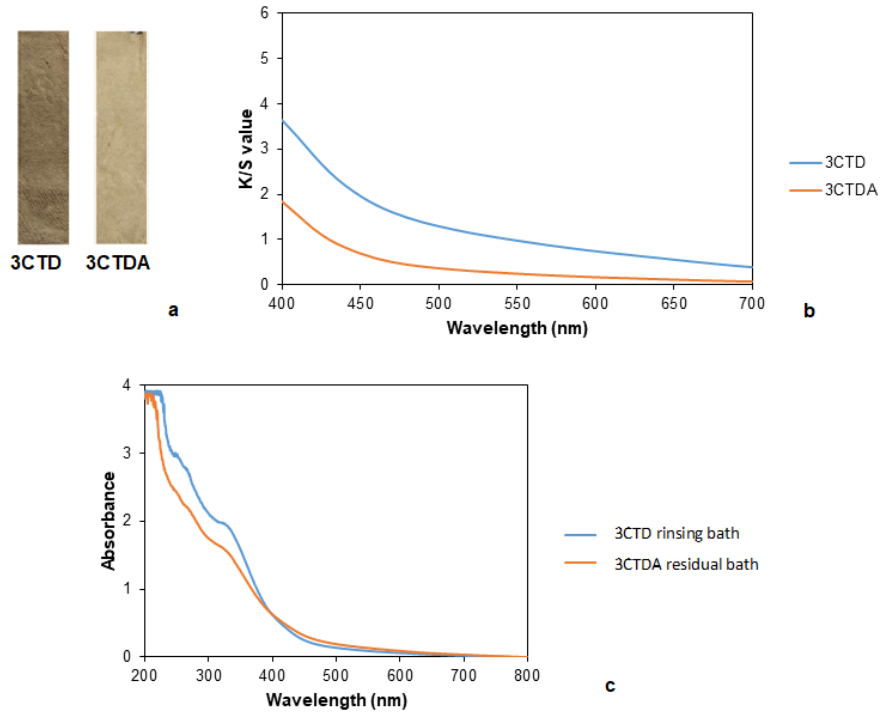
Figure 10. ( a ) Samples dyed with calendula without and with rinsing, ( b ) K/S values of the samples dyed with calendula without (3CTD) and with rinsing (3CTDA). ( c ) Absorbance curves of the residual dyeing bath and rinsing bath of the samples dyed with calendula. Table 15. Colorimetric values obtained for samples dyed with calendula without and with rinsing.